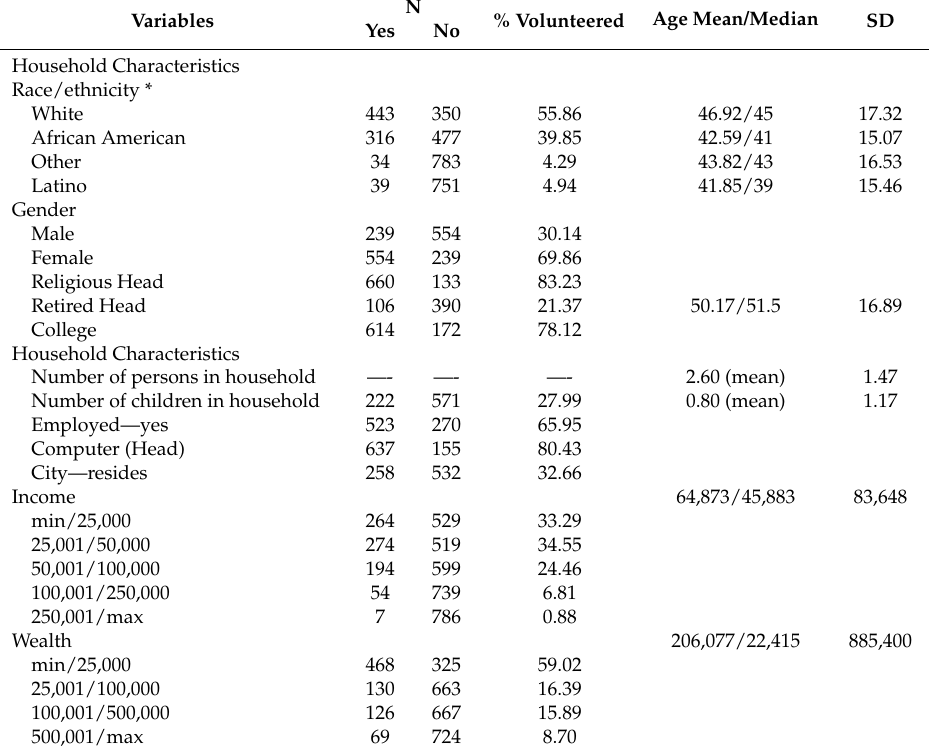
Table 3. Household characteristics of persons who did volunteer activities for organization in 2011; N = 793